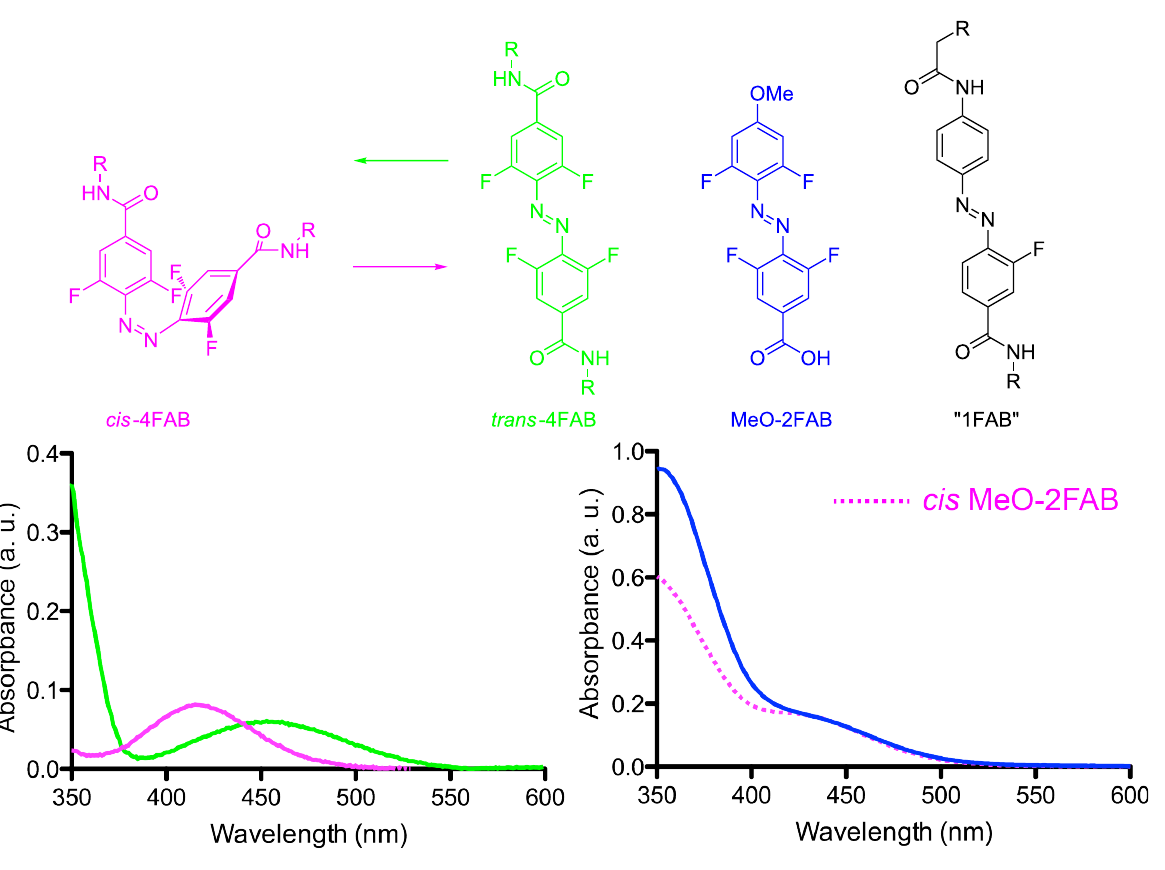
Figure 1: Fluoro-AB derivatives and spectra. Structures of 4FAB-diamides [13] cis and trans configurations, and the associated absorption spectra of these compounds (left). Note, the analogous difluoro-ABs have similar spectra to 4FABs [13]. Effect of electron donation on the fluoro-AB absorption spectra, the cis -MeO-2FAB (pink dots) is the green photostationary state of the photochrome (right). Structure of the photochrome core of a mono- fluoro-AB (1FAB) [18]. Spectra in HEPES, pH 7.4 at